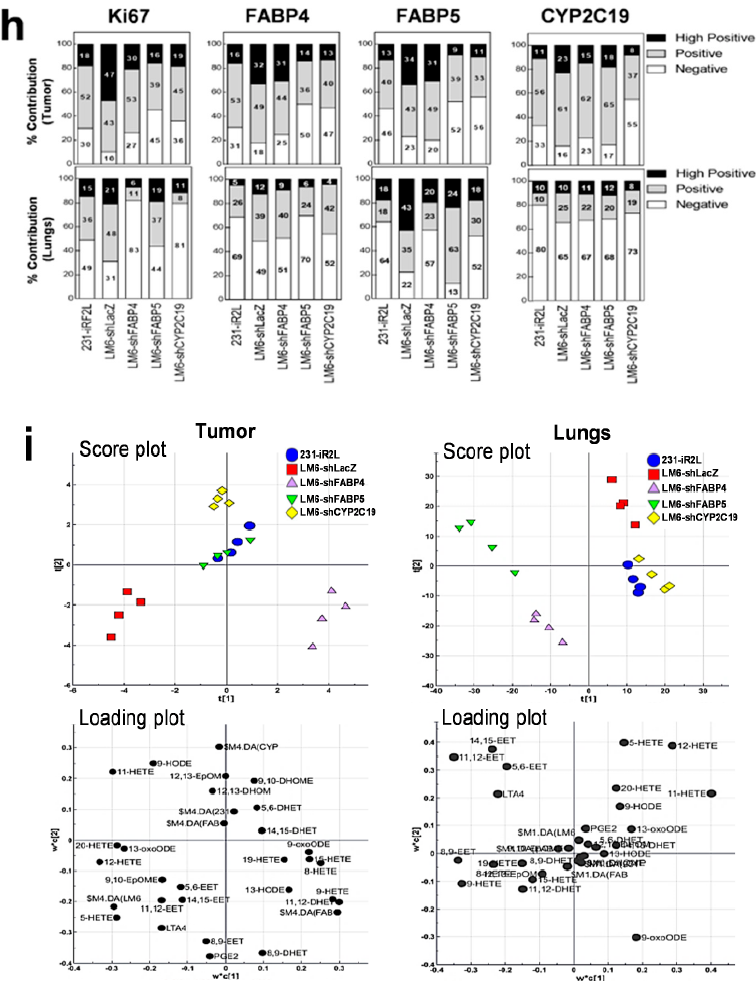
Figure 5. In vivo validation of the roles of CYP2C19, FABP4, and FABP5 in primary tumor growth, relapse, and metastasis. 231-iR2L, LM6, LM6-shFABP4, LM6-FABP5, and LM6-CYP2C19